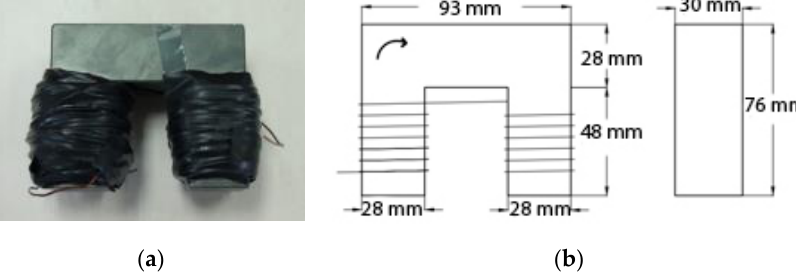
Figure 3. ( a ) Appearance of the magnetic probe and ( b ) detailed dimensions of the ferrite core.